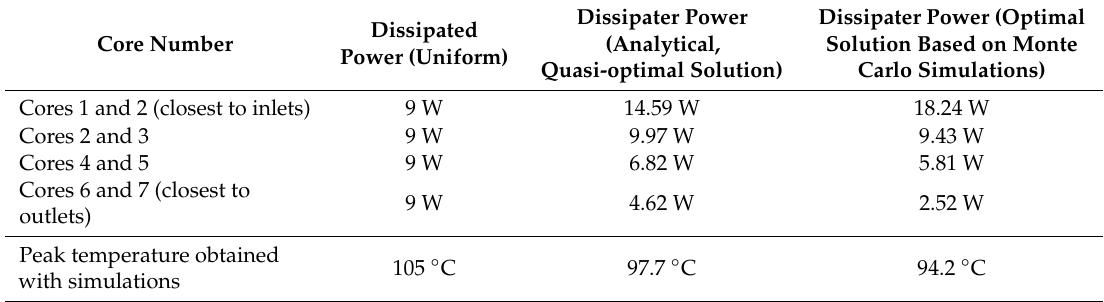
Table 3. Power dissipated in cores and the respective peak temperatures for three cases. Power dissipation in cores in the second processor layer is exactly the same, so it was not